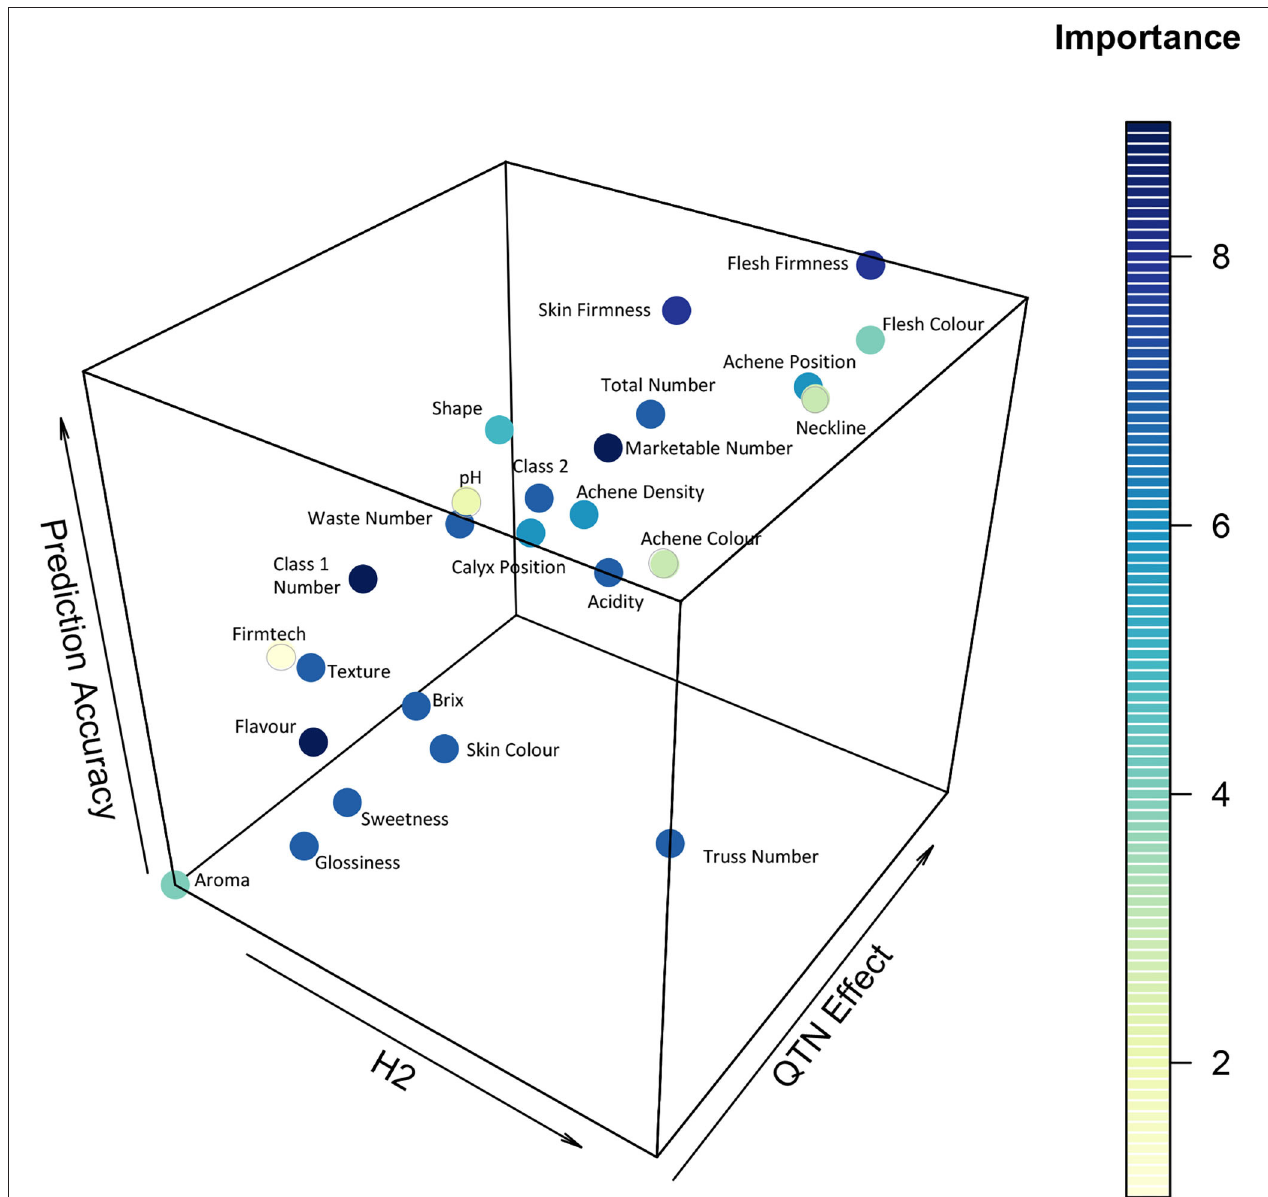
FIGURE 7 | Heritability (H2), QTN Effect is the total R 2 of identified alleles and prediction accuracy for strawberry yield and fruit quality traits as assessed across the multi-parental population. Dark blue represents the most important traits to select upon, yellow the least important